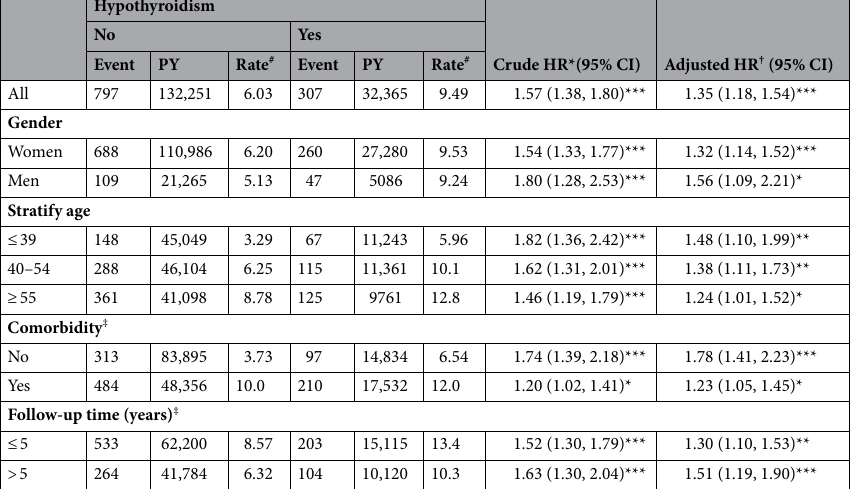
Table 2. Comparison of incidence densities of Tinnitus and hazard ratio between with and without Hypothyroidism by demographic characteristics and comorbidity. Rate # , incidence rate, per 1000 person-years; Crude HR*, relative hazard ratio; Adjusted HR † : multivariable analysis including age, and comorbidities of vertigo, insomnia, anxiety, and hearing loss; *p < 0.05, **p < 0.01, ***p < 0.001. Comorbidity ‡ : Patients with any one of the comorbidities vertigo, insomnia, anxiety, and hearing loss were classified as the comorbidity group. ‡ The follow-up time is partitioned into 2 segments (years ≤ 5, and > 5 years) by median.